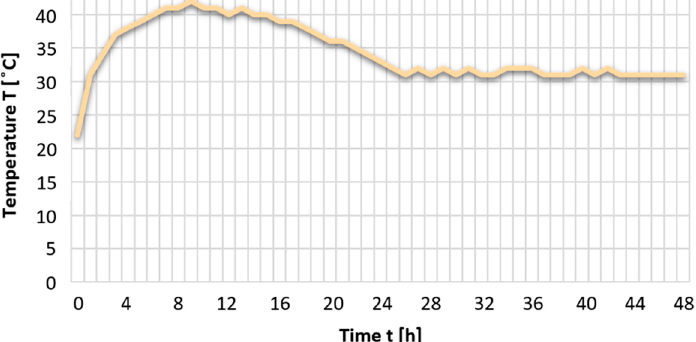
Figure 14. Graphic display of the course of temperature changes during the trial run.